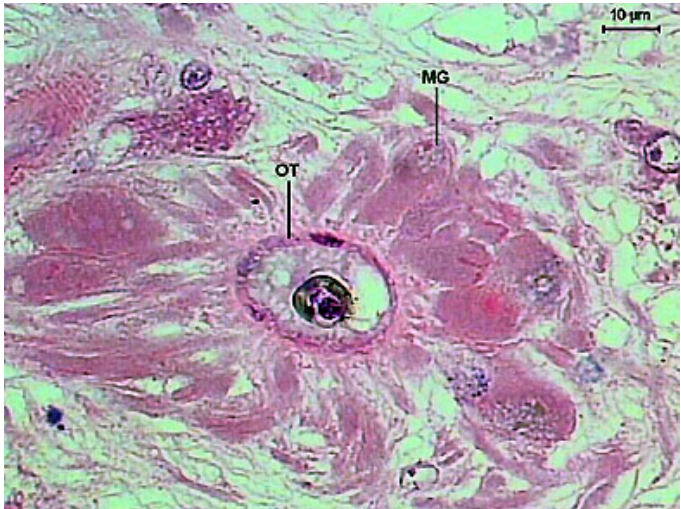
Figure 17. Detail of the Sticholecitha serpentis ootype (OT) and Mehlis’ gland (MG).